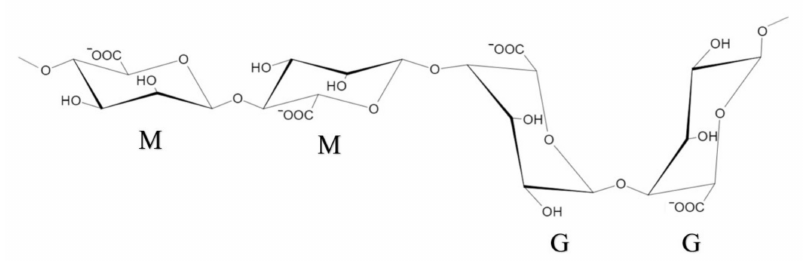
Figure 2. Structure of α − L -guluronic and β − D -mannuronic alginate residues.